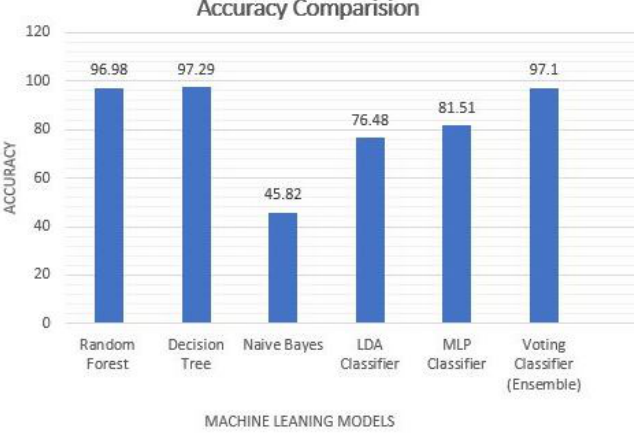
Figure 9. Accuracy comparison of ML models.